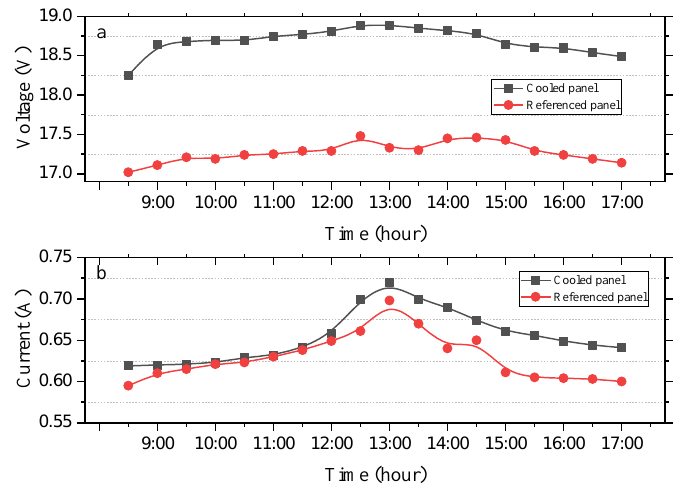
Figure 9. ( a ) Voltage ( b ) current. Inventions 2021 , 6 , 63